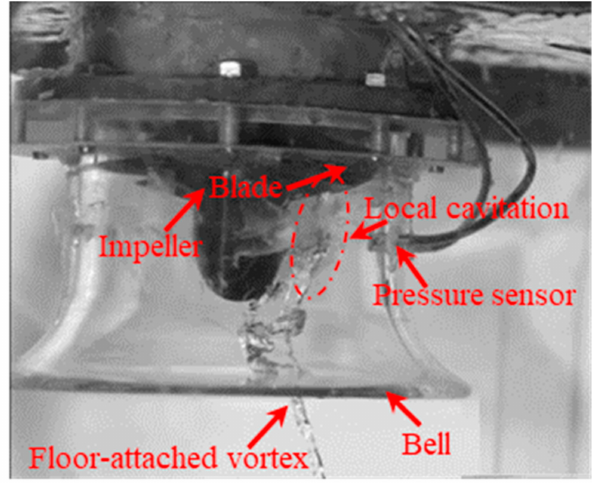
Figure 6. Experimental diagram of the FAV.